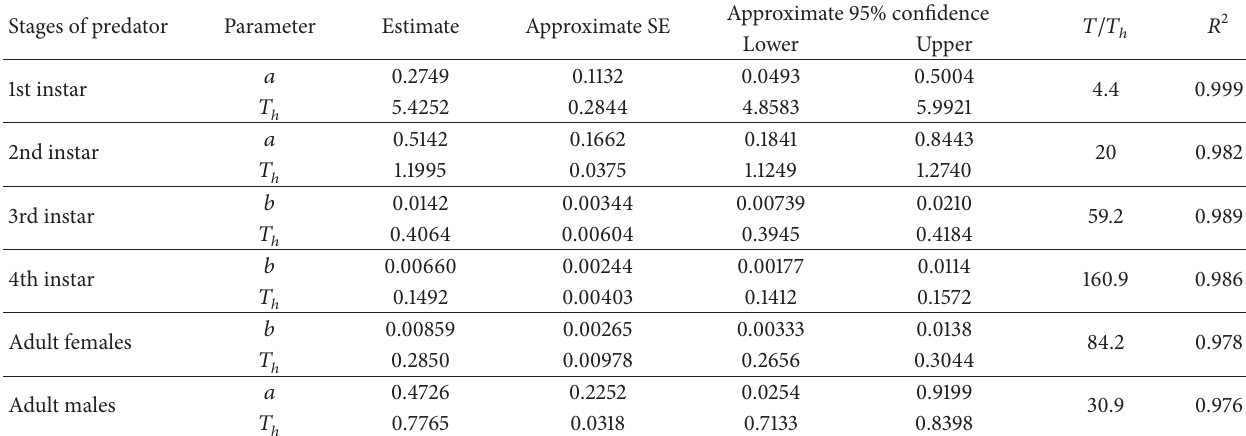
Table 2: Parameters estimated by Rogers’s random predator equation as well as 𝑅 2 and maximum predation rate ( 𝑇/𝑇 ℎ ) for six life stages of N. arcuatus fed on N. viridis